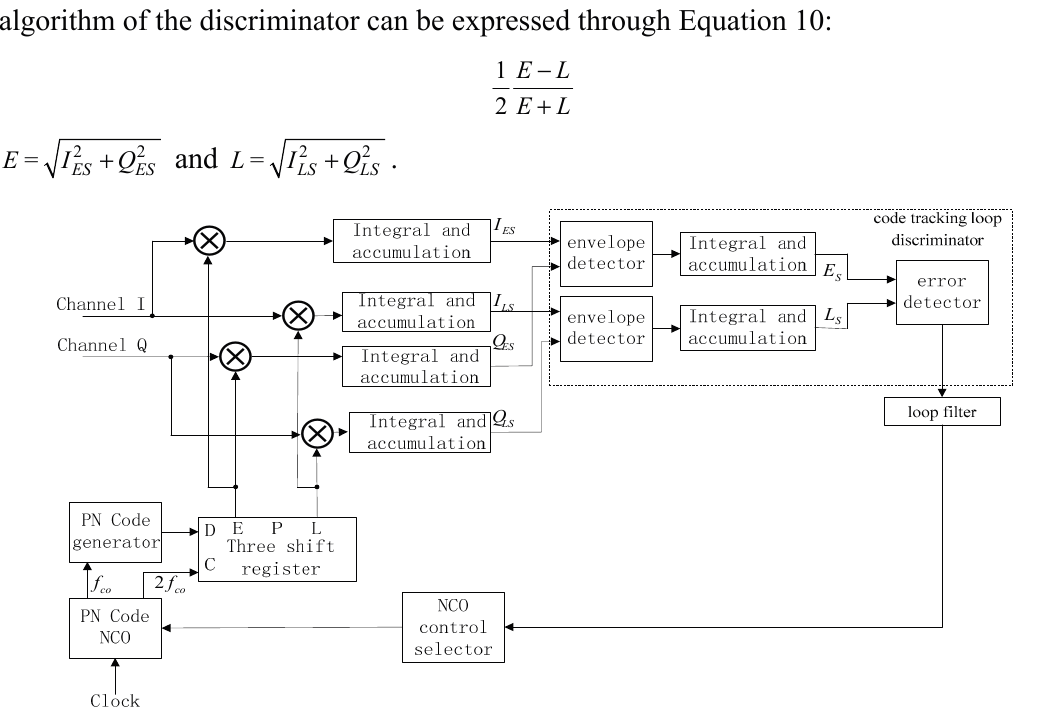
Figure 11. Block diagram of code tracking loop